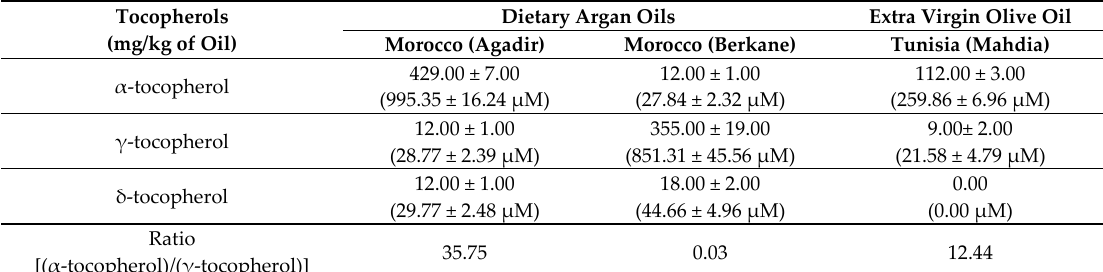
Table 3. Tocopherols contents of dietary argan oils (Agadir, Berkane; Morocco) and extra virgin olive oil (Madhia,